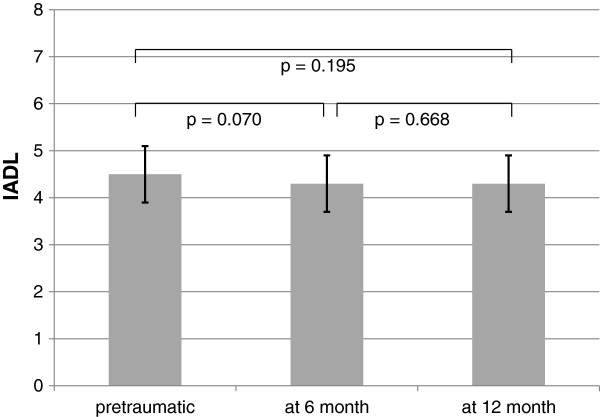
Activities of daily living: pretraumatic, at 6 month follow up and at 12 month follow up.